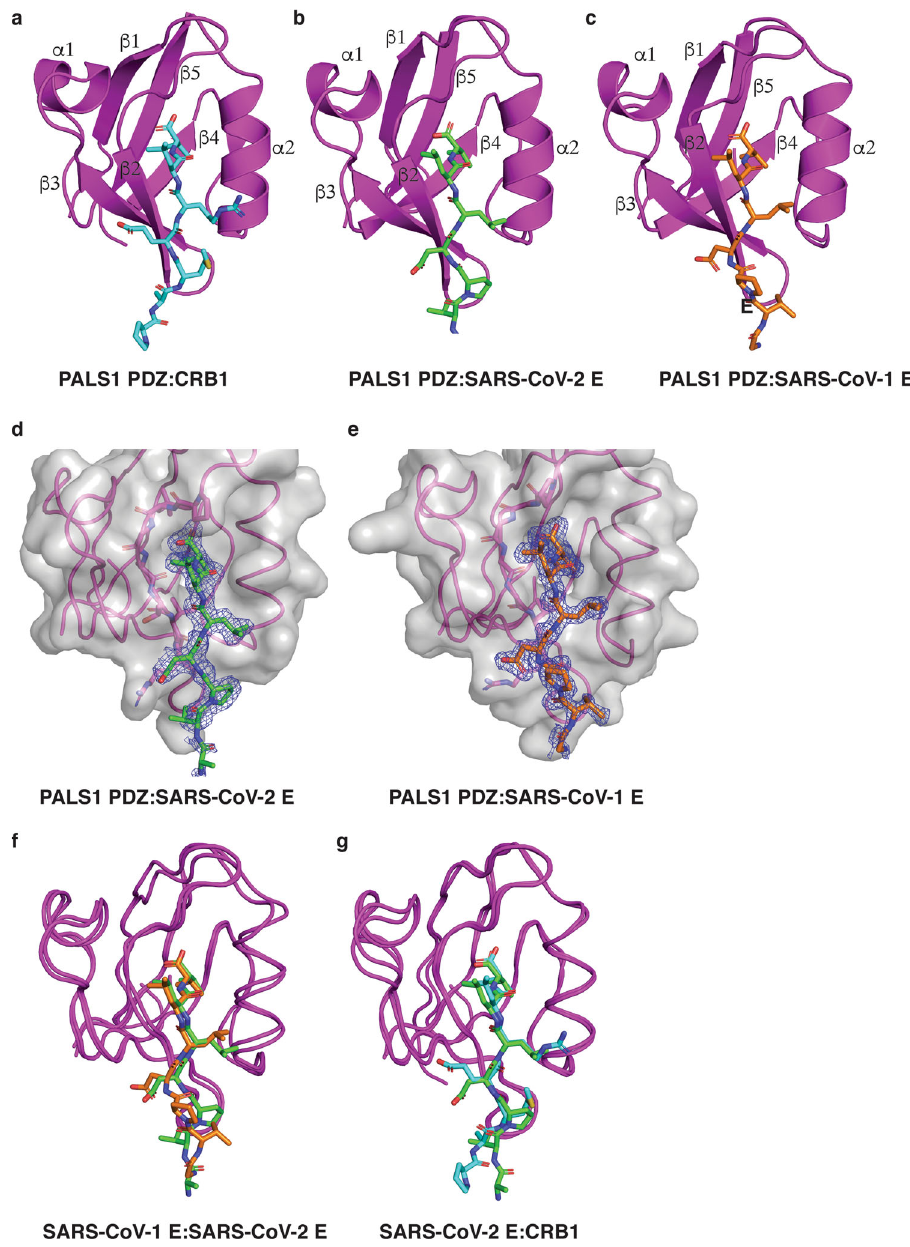
Fig. 2 The crystal structures of PALS1 PDZ bound to SARS-CoV-1 and SARS-CoV-2 E protein PBM. The E protein PBM peptide engages PALS1 PDZ via a shallow groove located between the β 2 and α 2. a Human PALS1 PDZ (magenta) is shown as a cartoon with a human CRB1 peptide (cyan) represented as sticks (PDB ID 4UU5) 29 . b PALS1 PDZ (magenta) is shown as a cartoon with SARS-CoV-2 E protein PBM (green) represented as sticks. c PALS1 PDZ (magenta) is shown as a cartoon with SARS-CoV-1 E protein PBM (orange) represented as sticks. d , e Electron density maps centred on the SARS-CoV-2 E protein PBM peptide (green) or SARS-CoV-1 protein PBM peptide (orange) in the binding groove of PALS1 PDZ. The electron density map is a 2Fo – Fc map shown as a blue mesh contoured at 1.5 σ . f Overlay of ribbon traces of PALS1 PDZ with SARS-CoV-2 E protein PBM (green) and PALS1 PDZ with SARS- CoV-1 E protein PBM peptide (orange). g Overlay of ribbon traces of PALS1 PDZ with SARS-CoV-2 E protein PBM (green) and human Crumbs peptide (cyan) peptide (PDB ID 4UU5) 29